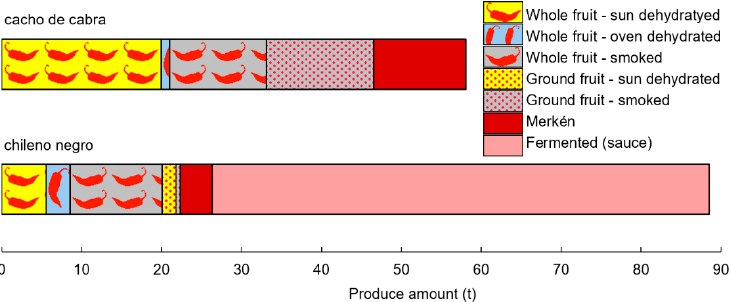
Figure 4. Amount of fruit processed (dry weight in t) by type of produce, by local farmers of two Chilean landraces.